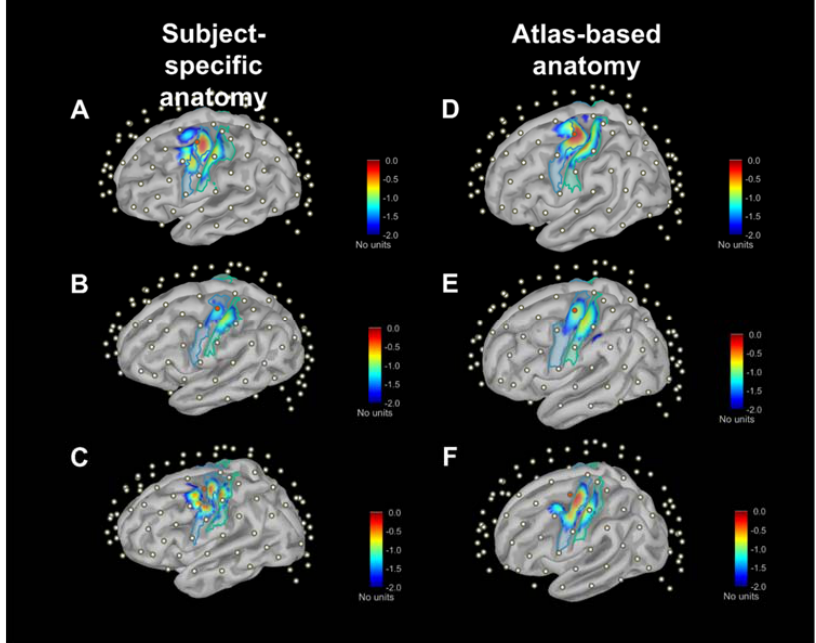
Figure 3. Graphical representation of channel ‐ wise sensitivity profile placed over motor areas (i.e., S9D7) across three SSAs ( A – C ) and ABAs (( D )—Colin27, ( E )—ICBM152, ( F )—FSAverage). The re ‐ spective cortical parcellations of precentral (dark blue) and postcentral (light blue) gyri are also in ‐ dicated. Sensitivity values are expressed as log (cid:2869)(cid:2868) (cid:4666)∙(cid:4667) adimensional units. Cortical surfaces were in ‐ flated at 40% for visualization purposes.